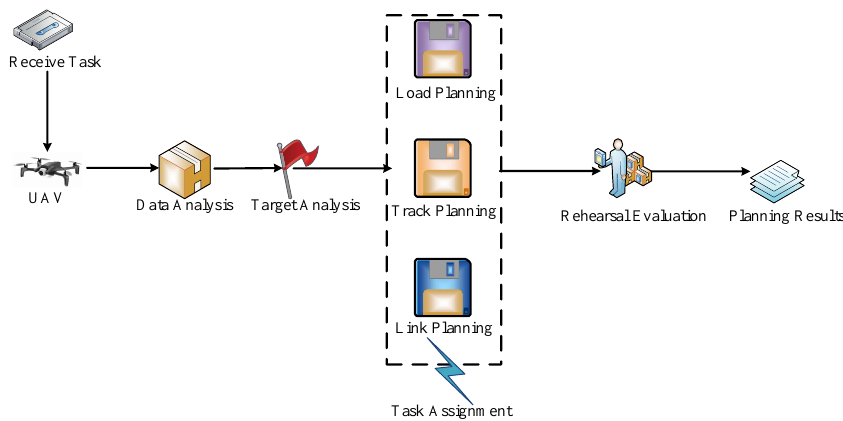
Figure 2. The specific process of UAV mission planning.